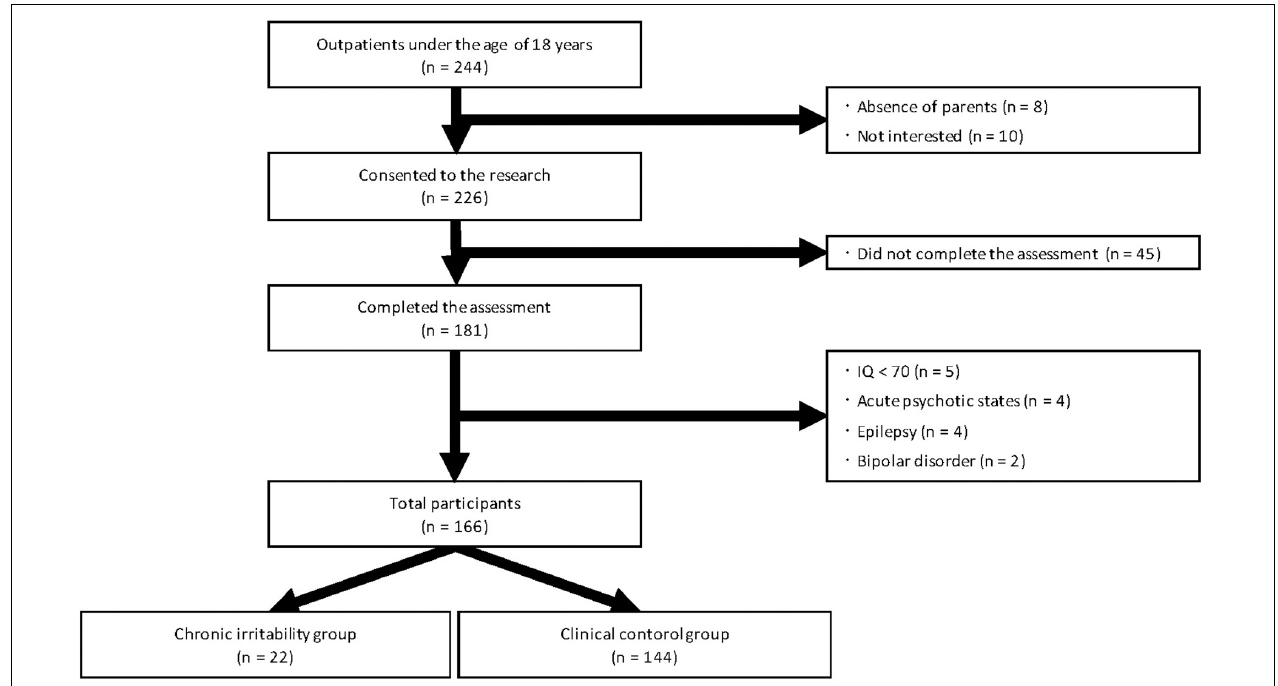
FIGURE 1 | Flow chart of the patient selection